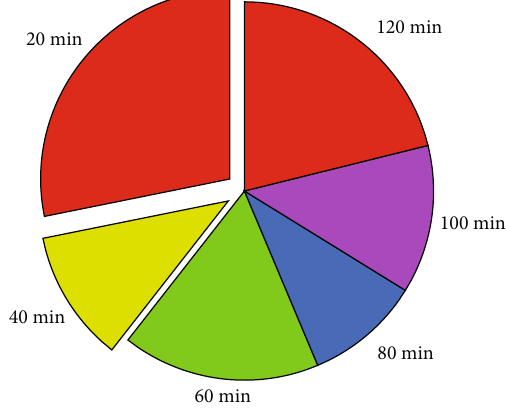
Figure 7: Classroom comprehensive